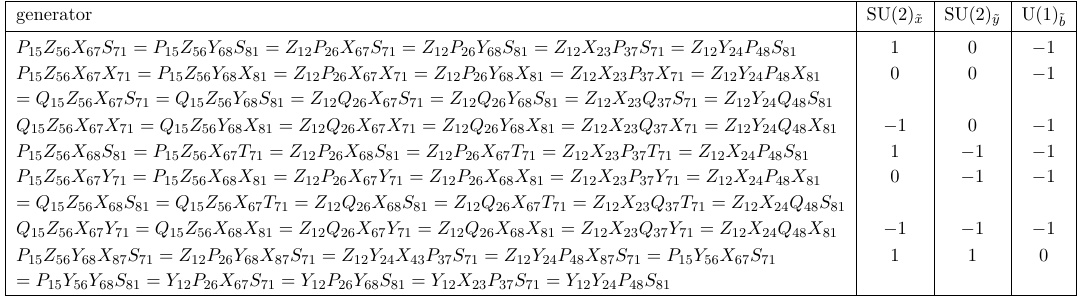
Table 45 . The generators in terms of bifundamental chiral fields for Model 11 (Part 1) .